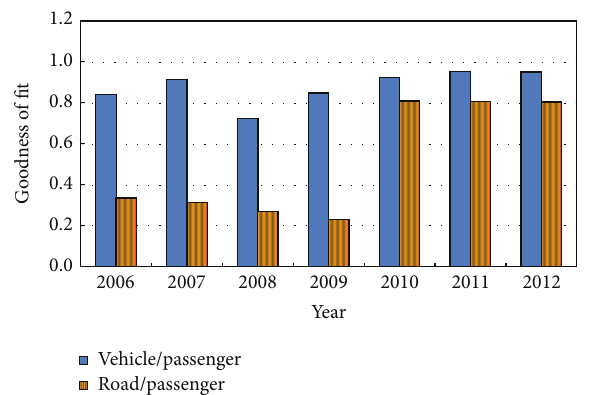
Figure 4: A histogram of the goodness of fit for the allometric scaling relations between vehicle/road and passenger